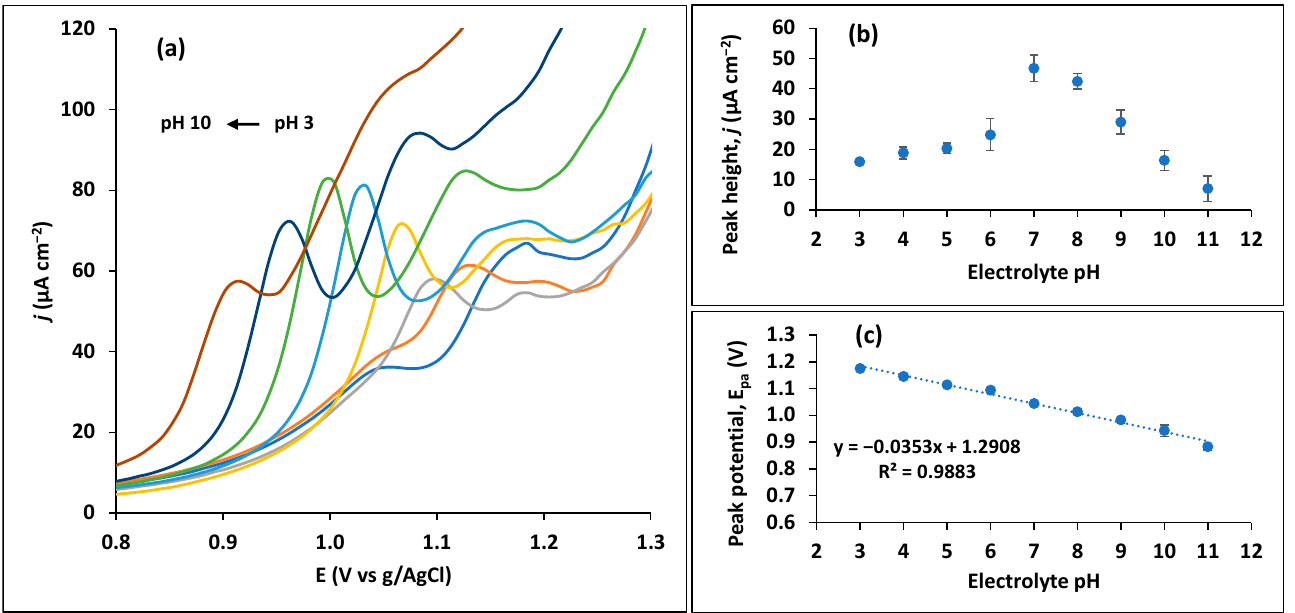
Figure 4. Optimization of electrolyte (0.1 M Britton–Robinson buffer) pH for 10 µM trimethoprim. ( a ) SWV curves from pH 3 to pH 12. ( b ) Influence of pH in trimethoprim peak height. ( c ) Influence of pH on trimethoprim peak potential.